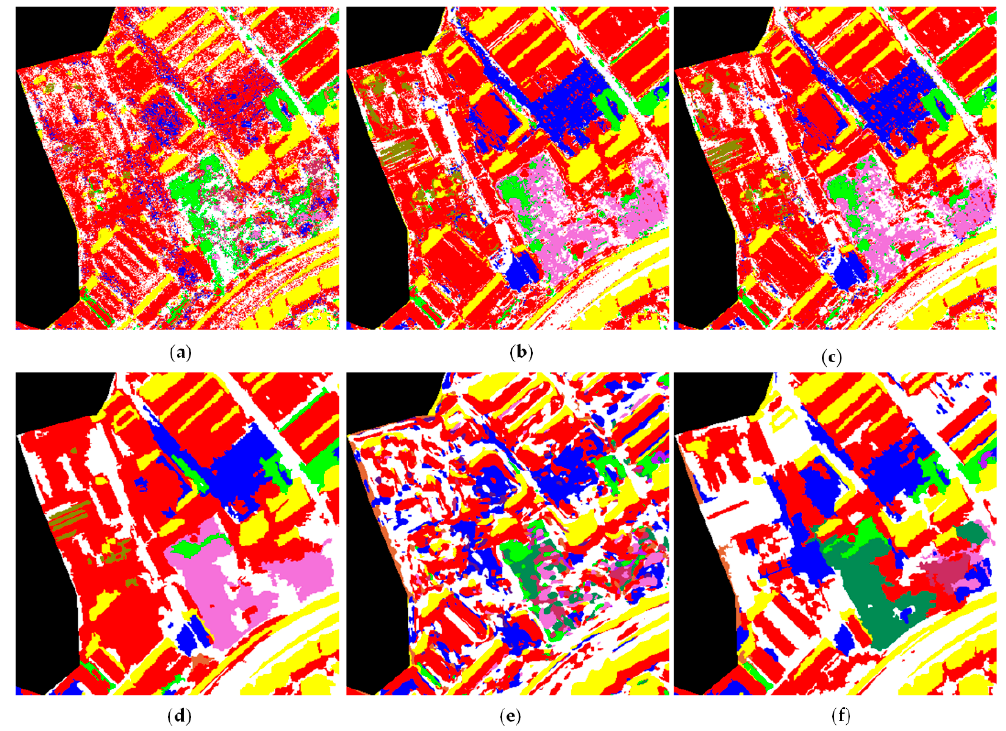
Figure 7. Local details of the classification results in wharf area. ( a ) Raw; ( b ) SS; ( c ) OSS; ( d ) OSS-MSSC; ( e ) VGG; ( f ) VGG-MSS.